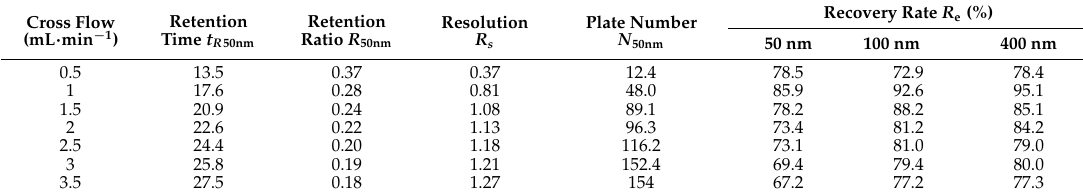
Table 2. Chromatographic parameters for the separation of a polystyrene nanoparticle mixture